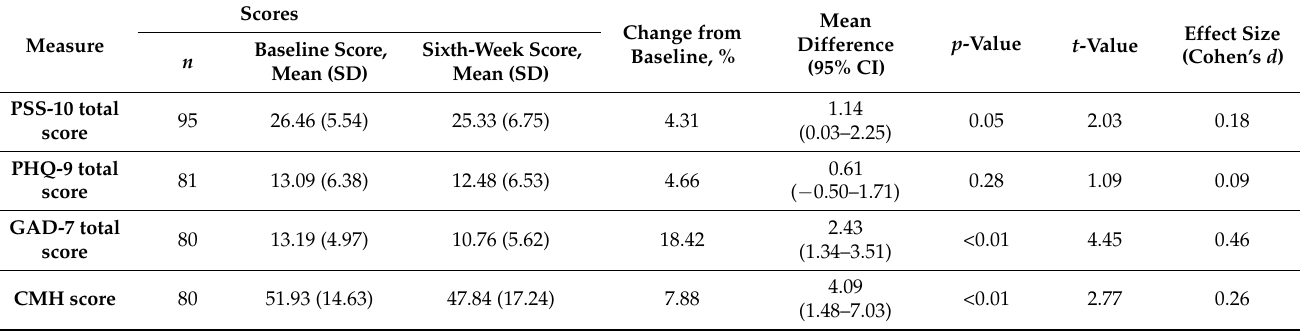
Table 3. Changes in baseline mean scores of PSS, PHQ-9, and GAD-7 after the introduction of Text4Hope.